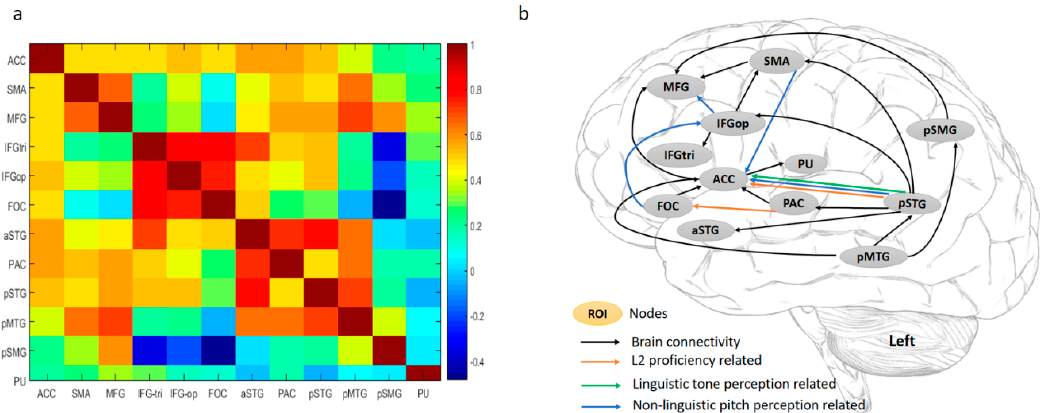
Figure 4. ( a ) Correlation matrix of BOLD signal changes in the regions of interest (ROIs) and ( b ) significant contemporaneous relationships between ROIs significant at the group level. ACC, anterior cingulate cortex; SMA, supplementary motor areas; MFG, middle frontal gyrus; IFGtri, inferior frontal gyrus, pars triangularis; IFGop, inferior frontal gyrus, pars opercularis; FOC, frontal operculum cortex; aSTG, anterior superior temporal gyrus; PAC, primary auditory cortex (Heschl’s gyrus); pSTG, posterior superior temporal gyrus; pMTG, posterior middle temporal gyrus; pSMG, posterior supramarginal gyrus; and PU, putamen. All regions are in the left hemisphere. A line with an arrow indicates a positive influence of one ROI on another. Lines in orange indicate that L2 proficiency is significantly and positively correlated with the connection strength of the brain pathway. Lines in green indicate that lexical tone perception ability is significantly and positively correlated with the connection strength of brain connectivity. Lines in blue indicate that non-linguistic pitch perception ability is significantly correlated with the connection strength of the brain connectivity: negative correlations for the FOC → IFGop, IFGop → MFG, and SMA → ACC pathways; positive correlation for the pSTG → ACC projection.